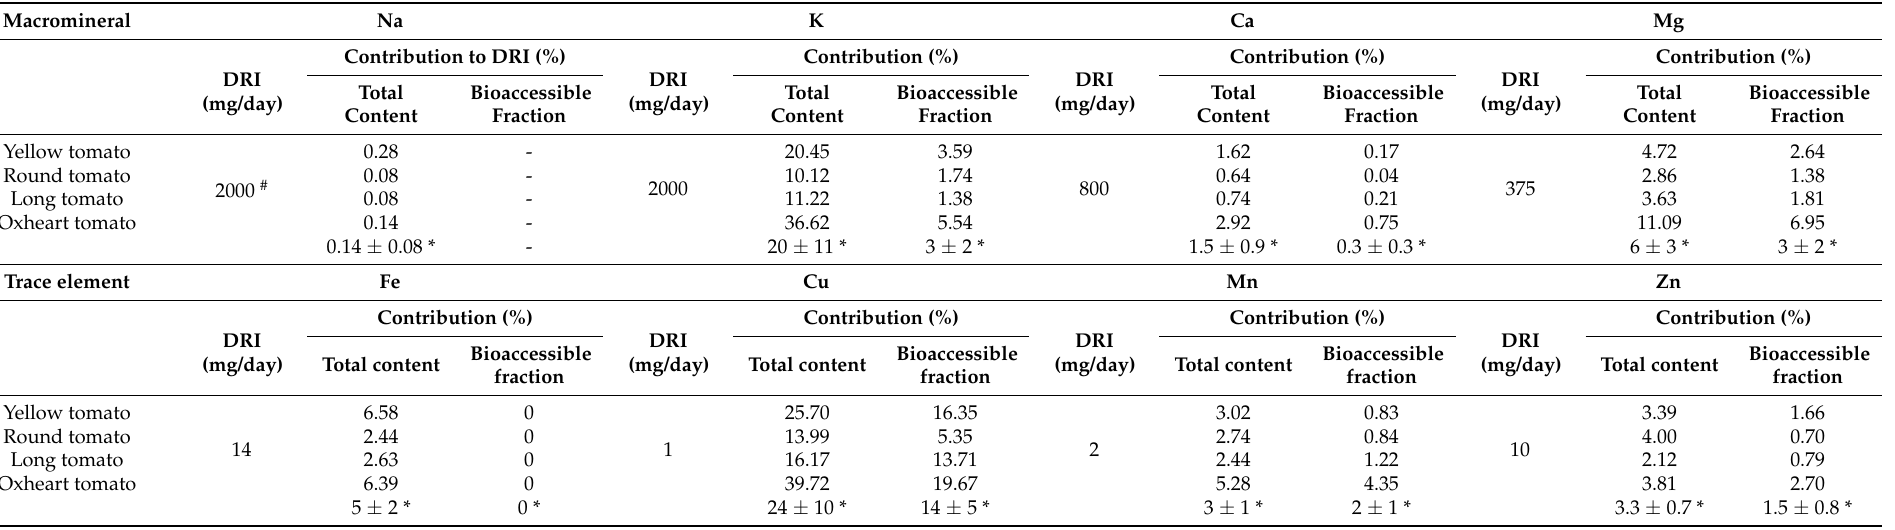
Table 4. Dietary reference intakes (DRIs) for minerals and contribution of the studied tomato farmers’ varieties (average per tomato fruit unit; see Table